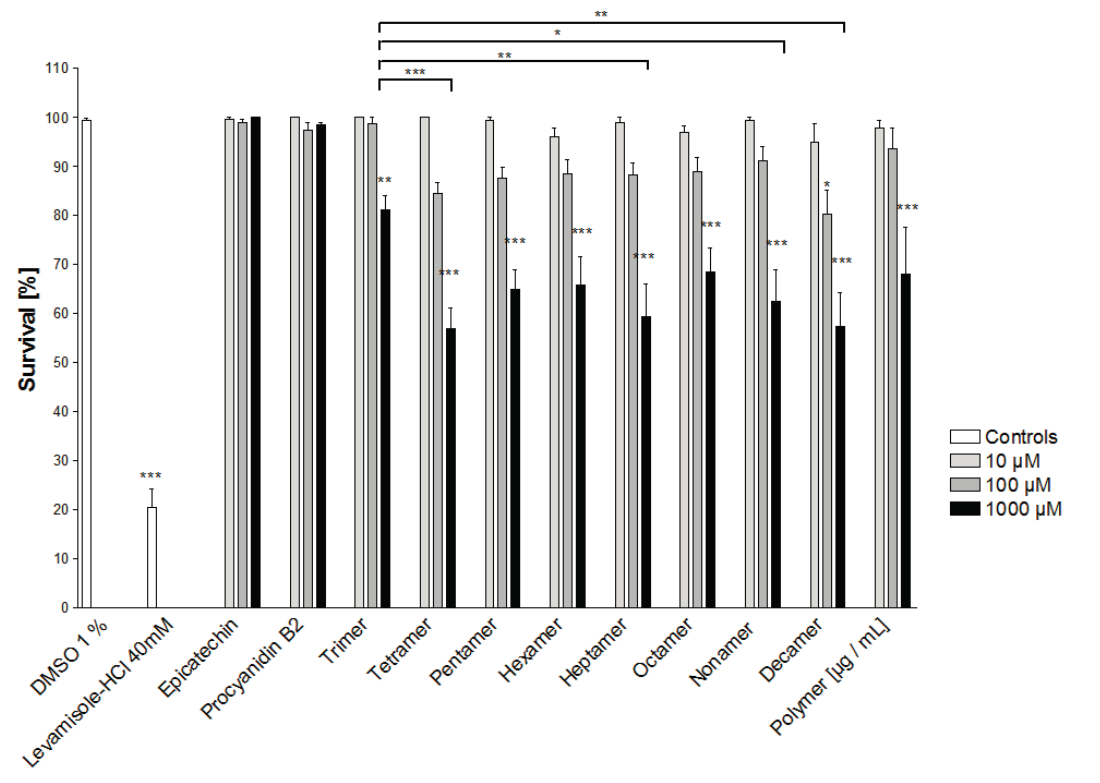
Figure 5. Anthelmintic activity of isolated procyanidin clusters against C. elegans. Untreated C. elegans in test medium containing 1 % DMSO served as negative control (NC), levamisole-HCl (40 mM) served as positive control. ** p < 0.01, *** p < 0.001 compared to NC. Brackets indicate significant differences in the activity among the OPC clusters DP3 to DP10 ( * p < 0.05, ** p < 0.01, *** p <